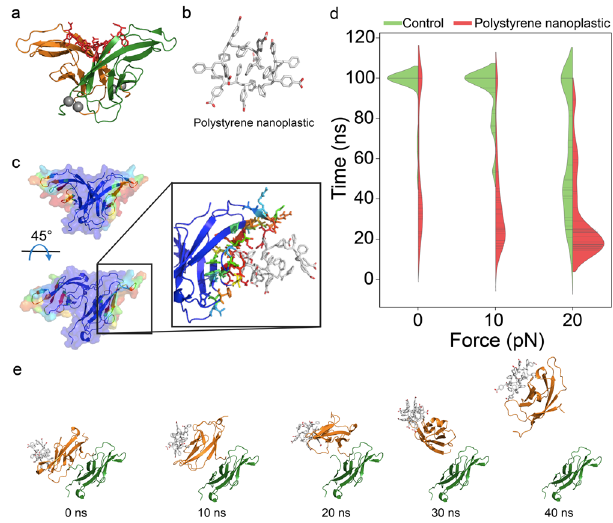
Fig. 5 | Discrete molecular dynamics (DMD) and steered DMD (sDMD) simula- tions of the binding frequency of polystyrene (PS) nanoplastic with a VE- cadherin dimer as well as cadherin dimer stability. a Structure of the EC1 cad- herin dimer. Red sticks and gray spheres indicate the domain-swapped region and calcium ions, respectively. b Structureof a carboxylatedPS nanoplasticafter 50ns equilibrium DMD simulation. c Colour-coded binding frequency of the PS nano- plasticontheEC1cadherindimersurface.Blueandredcolorsrepresentlowtohigh binding frequencies. The enlarged panel details nanoplastic binding with the EC1 dimer. d ViolinplotsofthedimerbindingwiththePSnanoplastic. e Representative dissociationtrajectoriesofthedimerinthepresenceofthePSnanoplasticunder0 pN of